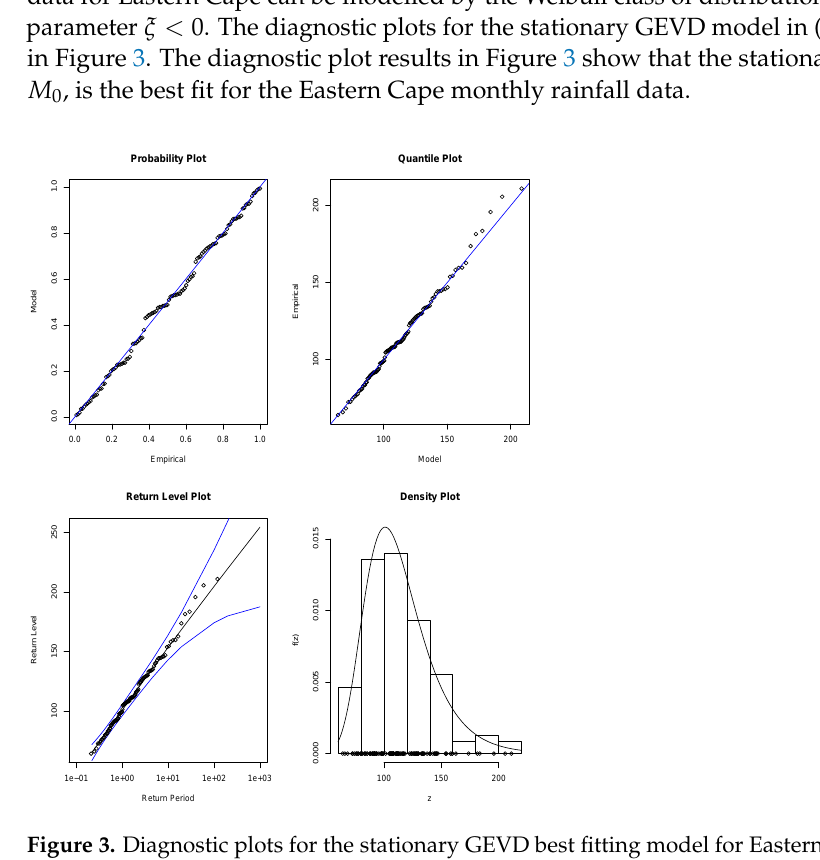
Figure 3. Diagnostic plots for the stationary GEVD best fitting model for Eastern Cape province. Goodness-of-fit test for Eastern Cape GEVD model The goodness-of-fit test based on Kolmogorov-Smirnov (K-S) and Anderson-Darling (A-D) tests were performed in order to check if the maximum monthly rainfall data for Eastern Cape follow a stationary GEVD model. Table 6 presents the results of the K-S and A-D goodness-of-fit tests for the selected stationary GEVD model for Eastern Cape. The hypotheses are formulated as follows H 0 : The monthly rainfall data follow a specified